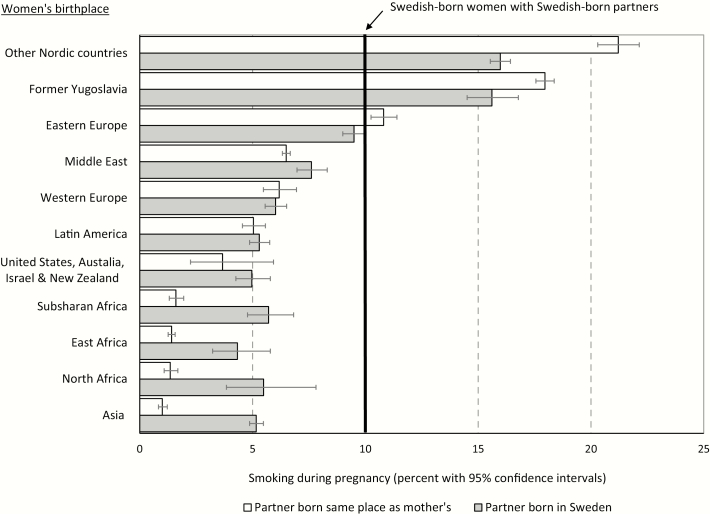
Adjusted prevalence of smoking during pregnancy with 95% confidence intervals, by women’s and partners’ birthplace, Swedish pregnancies, 1991–2012. Prevalence of smoking adjusted for maternal age groups, paternal age, household income (quintiles), rural residence, cohabitation status, parity, year of arrival to Sweden, and age at arrival to Sweden. All differences in the smoking prevalence between foreign-born women with foreign-born partners versus foreign-born women with Swedish-born partners are statistically significant at p < .001, with the exception of those from Western Europe, United States, Australia, New Zealand and Israel, and Latin America.